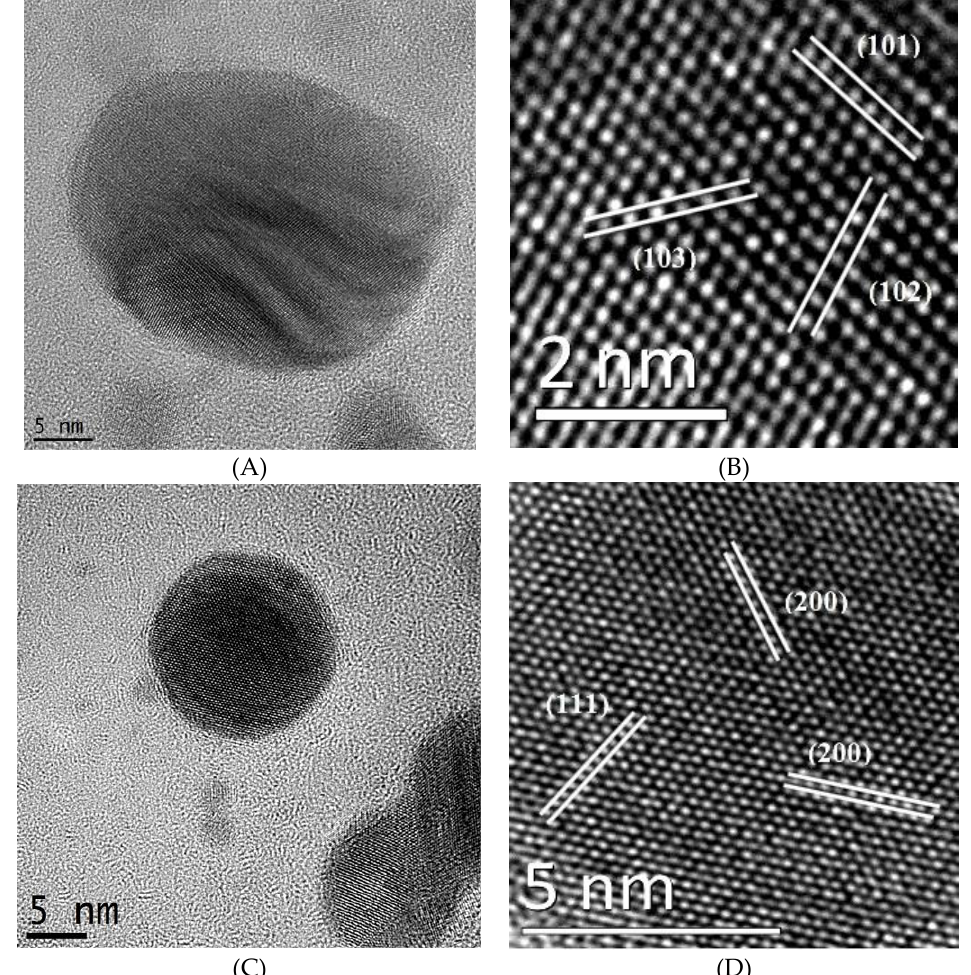
Figure 3. Representative HR-TEM micrographs of AgNPs taken at ( A ) Focus of a nanoparticle with an approximate diameter of 25 nm, ( B ) The interplanar spaces found from the electron diffraction pattern correspond to a compact hexagonal structure. ( C ) Focus of a nanoparticle with an approximate diameter of 17 nm. ( D ) Nanoparticle with face centered cubic structure.